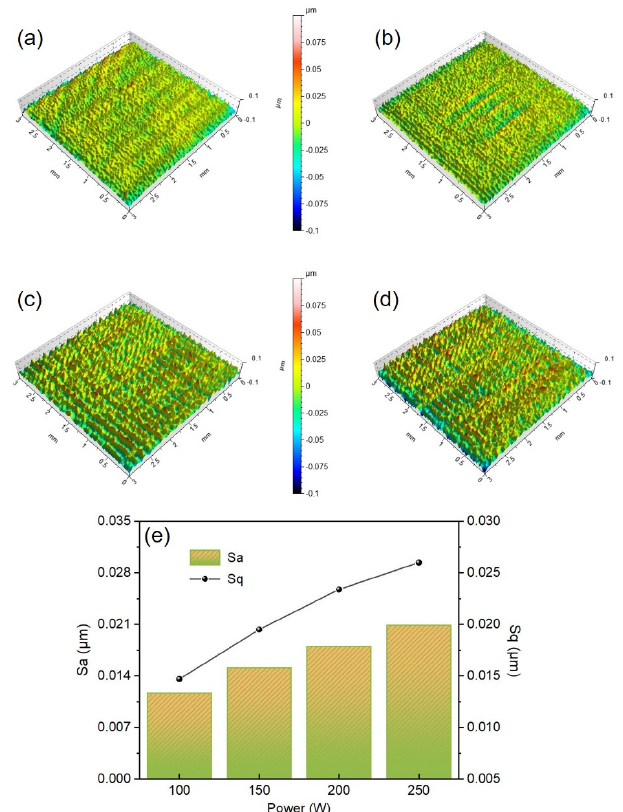
Figure 7. The 3D surface morphology of Cr coatings under di ff erent powers: ( a ) 100 W; ( b ) 150 W; ( c ) 200 W; ( d ) 250 W. ( e ) Surface roughness of Cr coatings under di ff erent powers.